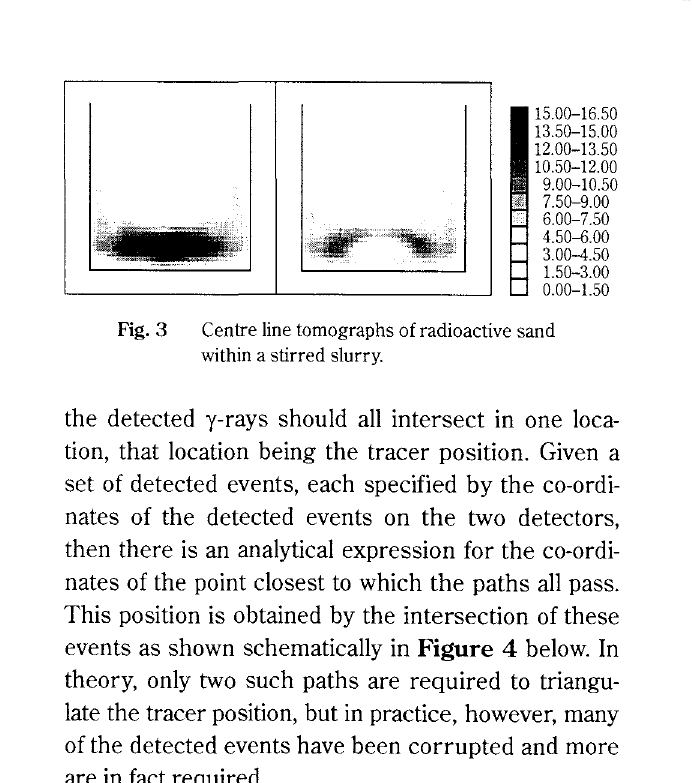
Fig. 3 Centre line tomographs of radioactive sand within a stirred slurry.